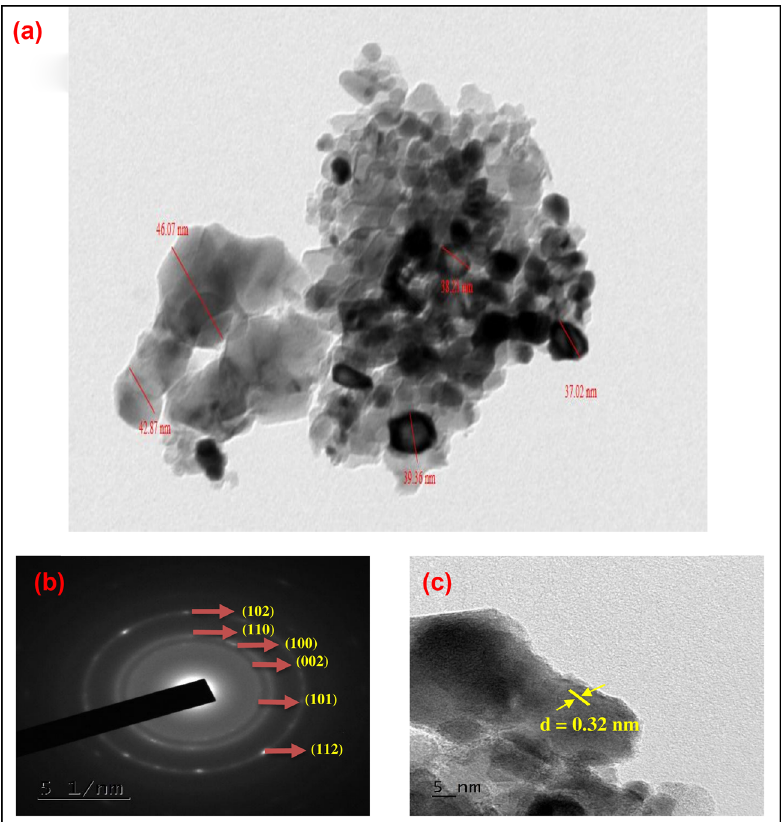
Figure 7: TEM image of phyto - fabricated ZnO NPs from S. acuta ( a ) , SAED pattern of ZnO NPs ( b ) , and HR - TEM with d - spacing ( c )